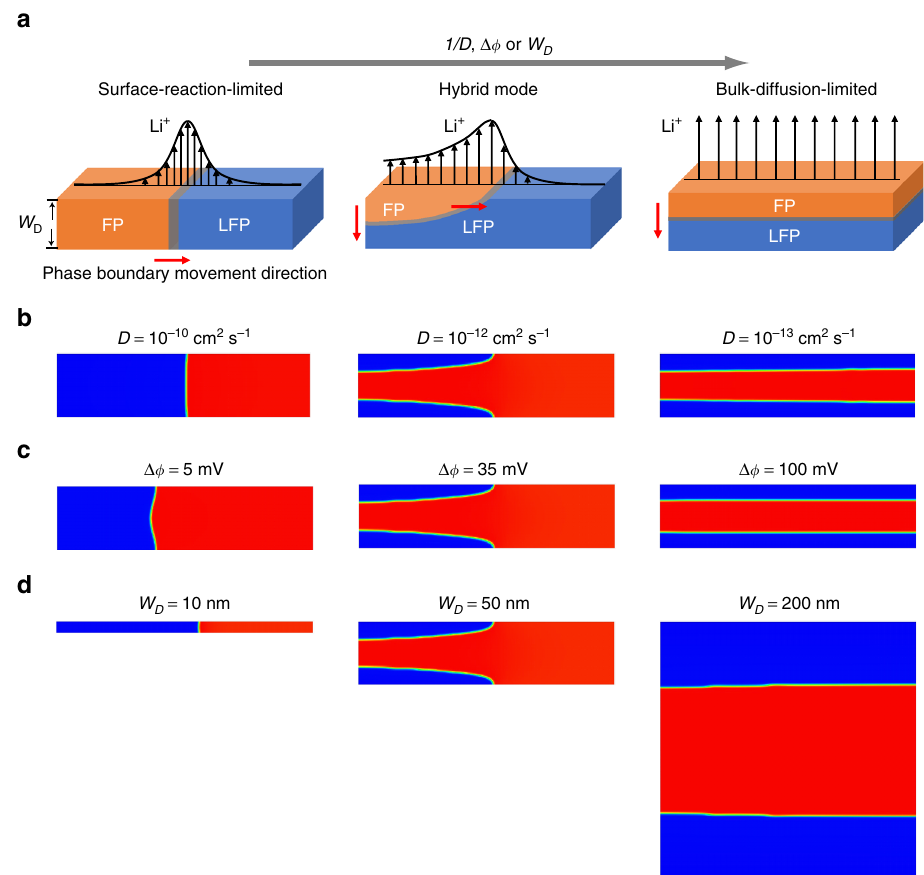
Fig. 6 Different phase-transformation mechanisms in LiFePO 4 . a Schematics of three kinetic regimes of phase-boundary migration in intercalation compounds, from left to right: SRL, hybrid, and BDL mode. Phase- fi eld simulations illustrate the transition from SRL to hybrid and then BDL-boundary movement in LiFePO 4 upon b , decreasing Li diffusivity D , c increasing overpotential Δ ϕ and d increasing particle thickness along the main Li intercalation direction W D . An exchange current density of j 0 = 1 A m – 2 and 2D Li diffusivity are used in all simulations. Δ ϕ = 35 mV and W D = 50 nm for simulations shown in b , D = 10 − 12 cm 2 and W D = 50 nm for simulations in c , and D = 10 − 12 cm 2 s − 1 and Δ ϕ = 35 mV for simulations in